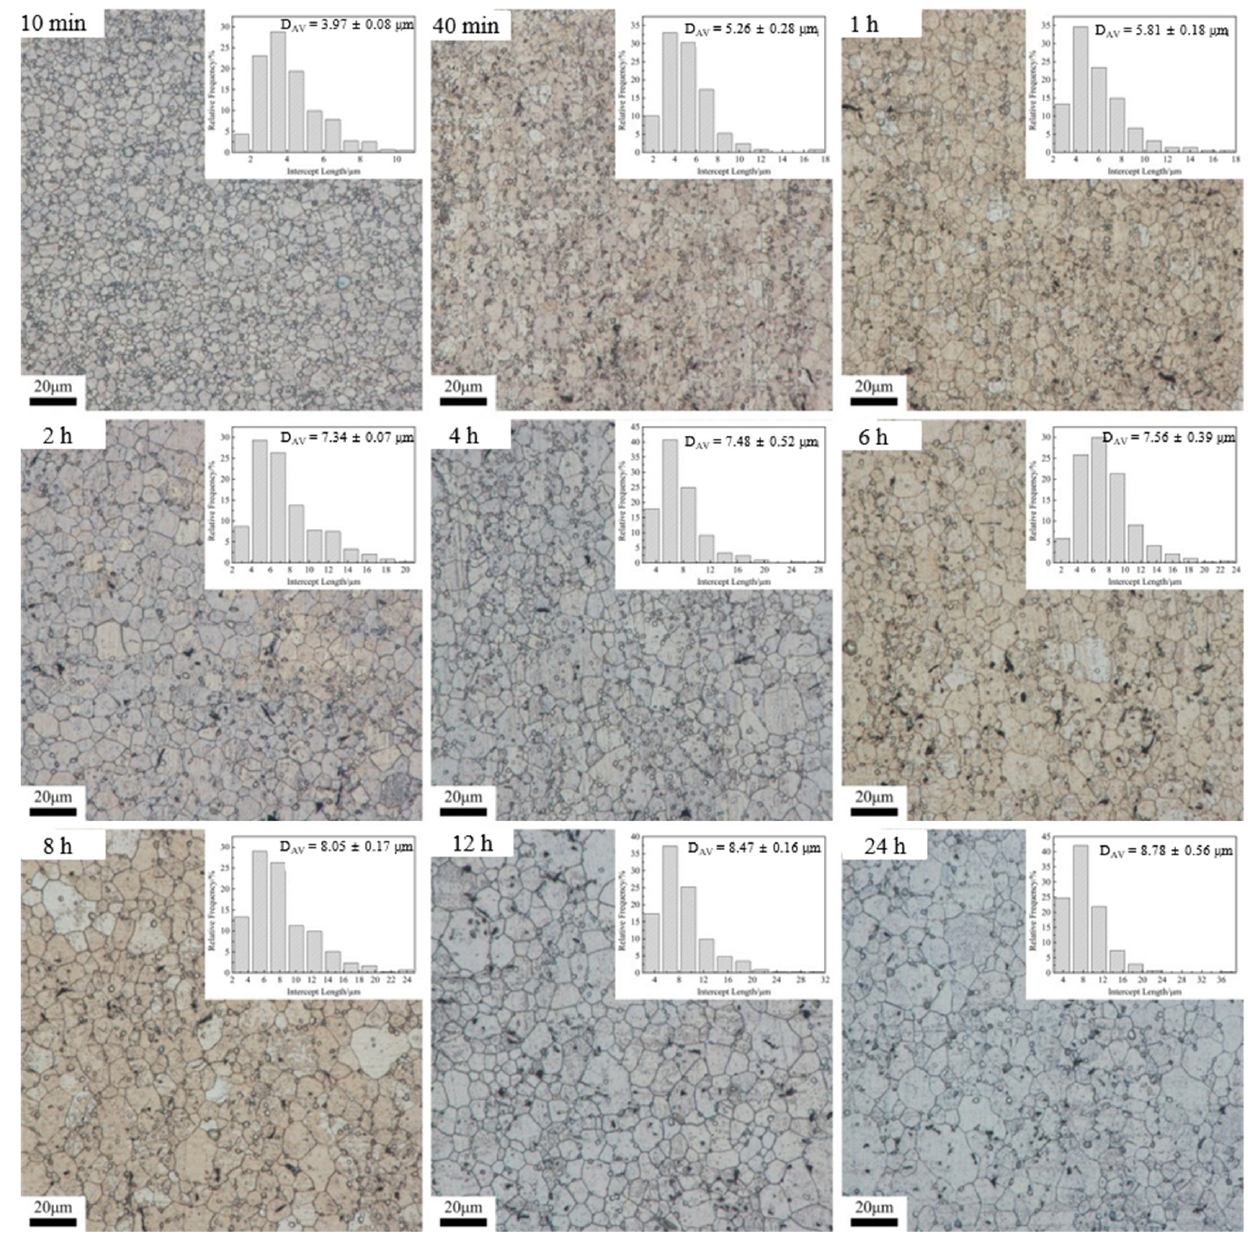
Figure 2. Optical micrographs and the corresponding grain-size distribution histograms obtained upon heat treatment at 470 °C.